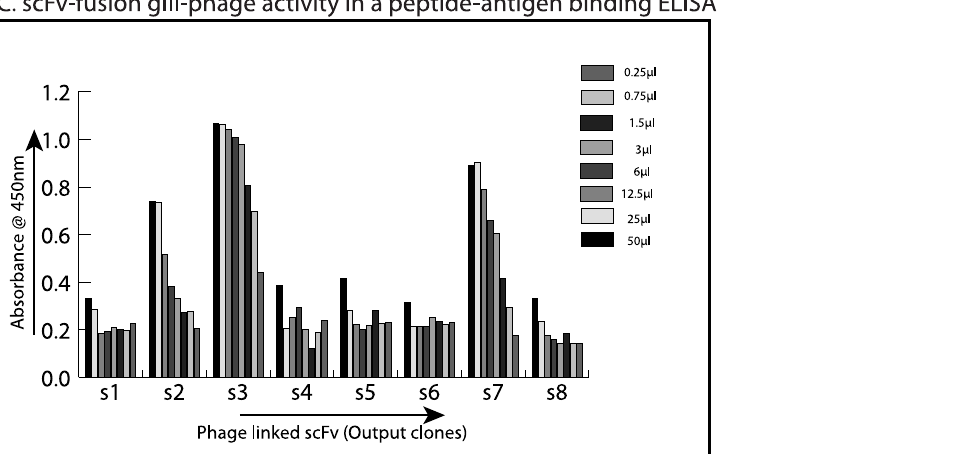
PLOS ONE | DOI:10.1371/journal.pone.0148366 February 19,